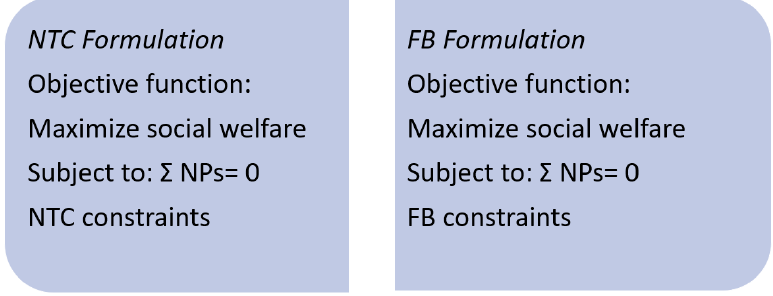
Figure 1. Formulation of the NTC and FB